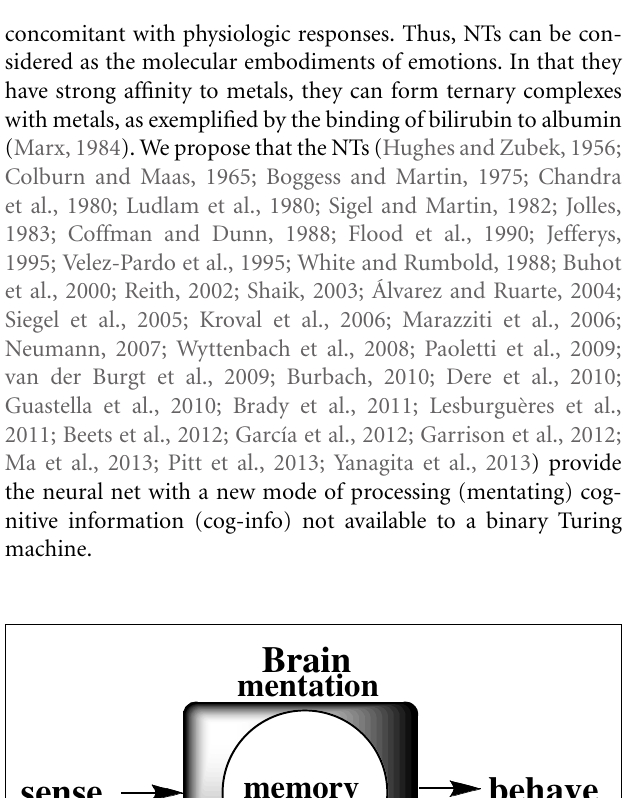
neurons) (with permission). (C) Painting by Jackson Pollok (Boole, 1853) that more closely represents neurons enmeshed within the nECM. (No empty spaces). (with